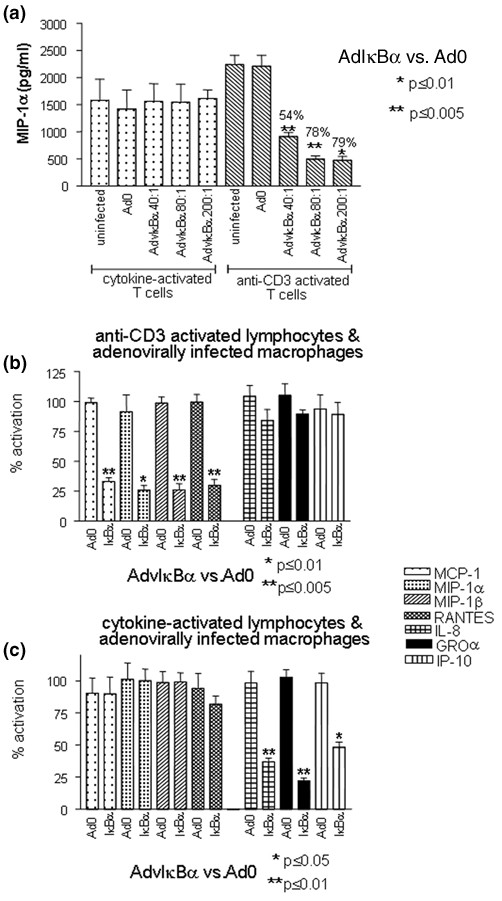
Differential utilization of NFκB in activated-T-cell contact-dependent chemokine production by human macrophages. Macrophage-colony stimulating factor-differentiated monocytes were infected with AdIκBα or Ad0, an empty control virus. After a further 2 days of culture and replating, anti-CD3-activated T cells (Ttcr cells) and cytokine-activated T cells (Tck cells) were added at a lymphocyte:monocyte ratio of 7:1. After 18 hours, culture supernatants were isolated and levels of CC chemokines (monocyte chemoattractant protein 1 (MCP-1), macrophage inflammatory protein 1 alpha (MIP-1α), macrophage inflammatory protein 1 beta (MIP-1β), RANTES) and CXC chemokines (IL-8, growth-related gene product alpha (GROα) and interferon-gamma-inducible protein (IP-10)) were measured simultaneously by ELISA. (a) MIP-1α levels in uninfected, Ad0-infected (multiplicity of infection (MOI) 200:1) and AdIκBα-infected (MOI 40:1, 80:1 and 200:1) monocyte cultures when stimulated with Ttcr-cells or Tck-cells. (b) and (c) Levels of CC and CXC chemokines in Ad0-infected and AdIκBα-infected monocytes (MOI 80:1) following stimulation with (b) Ttcr cells and (c) Tck cells. Data represent the mean of triplicate cultures ± standard deviation and are representative of at least three experiments. Statistically significant reduction in chemokine levels in AdvIκBα-infected (as compared with Ad0-infected) cultures is indicated.